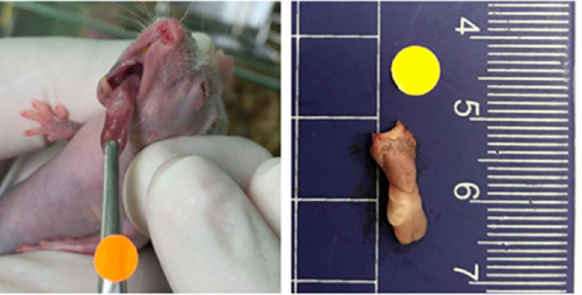
Figure 1. Orthotopic tongue cancer developed by submucosal injection with CAL-27 cells. A round- shaped marker with a 0.5 cm diameter was placed on the forceps when taking tumor photographs.